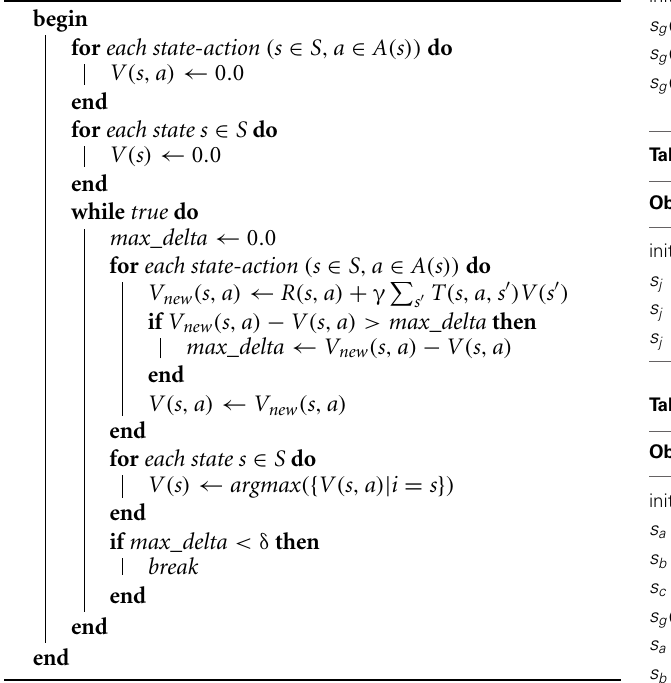
Algorithm 3: Value_Iteration(S,A,T,R, γ , δ )